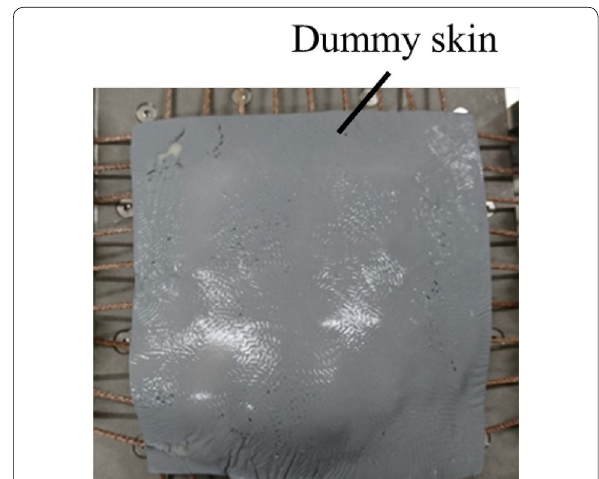
Fig. 7 Shape reproduced with dummy